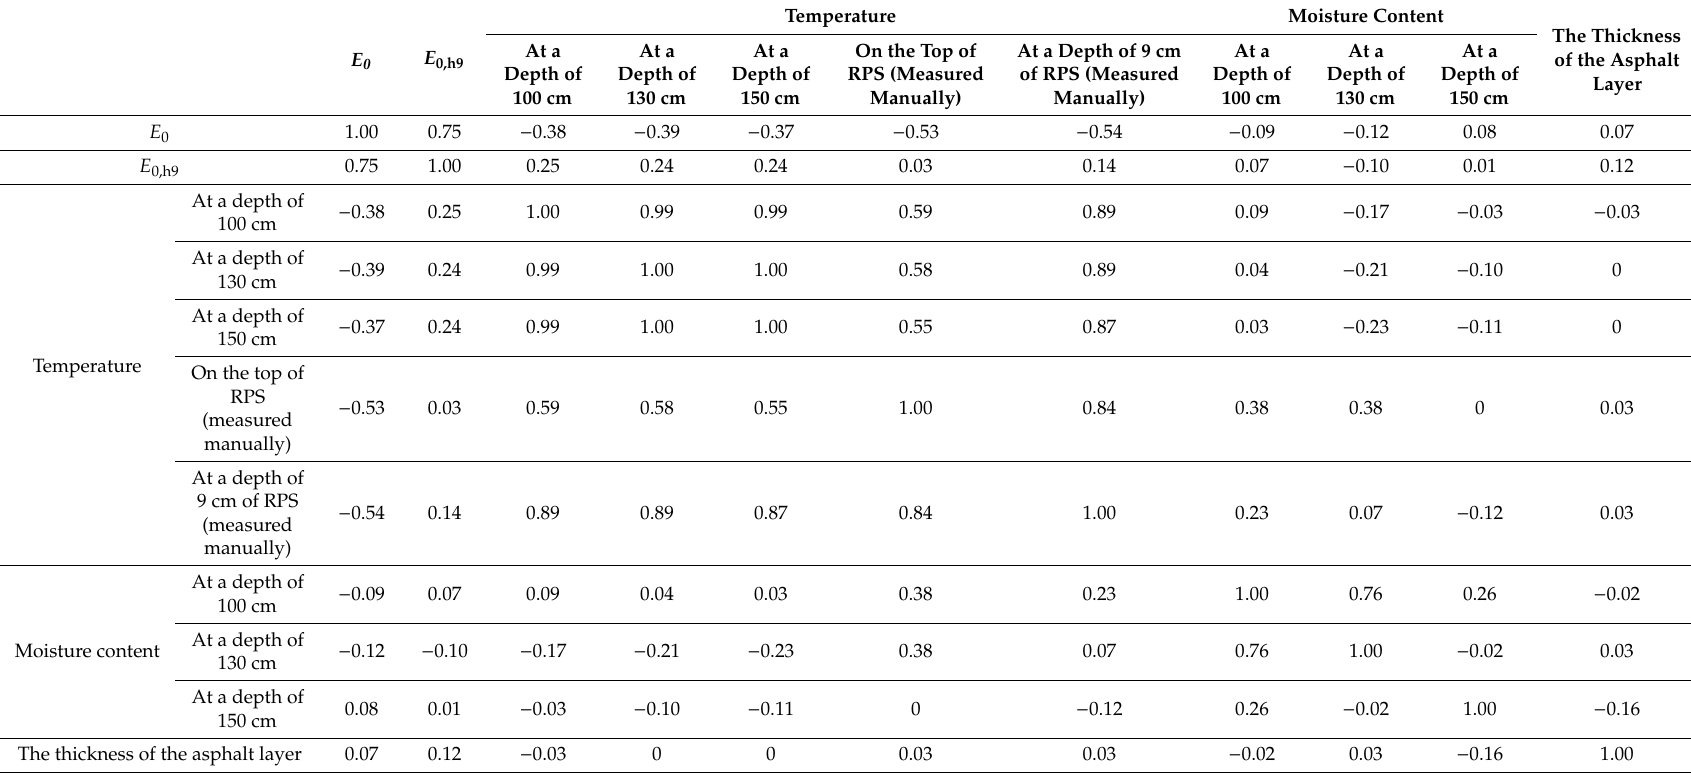
Table 3. Correlation of temperatures and moisture content at di ff erent depths of the asphalt concrete